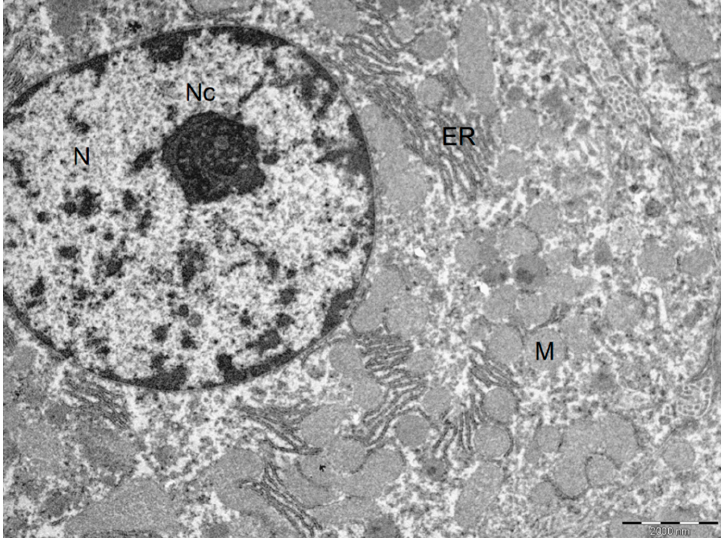
Figure 4. Ultrastructural characteristics with the addition of BBR in the liver preservation solution preserved the normal liver architecture after I/R injury. Normal hepatocyte. Cytoplasm with plasma membranes of adjacent hepatocytes are closely apposed and linear. Mitochondria are homogeneous in size and structure with normal membranes, cristae, matrices and dense calcium-sequestering granules. Abbreviations: N, nucleus; Nc, nucleolus; M, mitochondria; ER, endoplasmic reticulum. Scale bar: 2000 nm